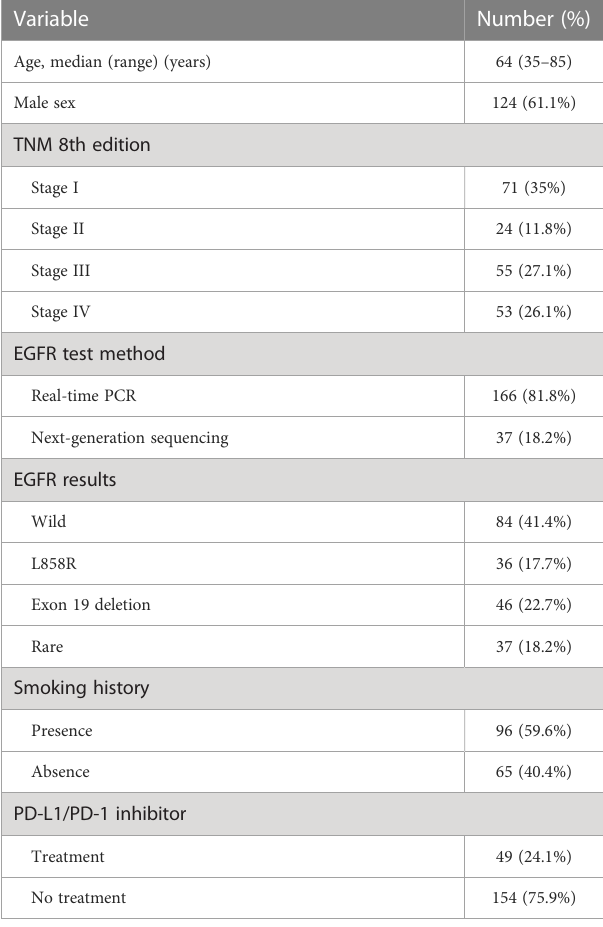
TABLE 1 Demographic and clinical characteristics of